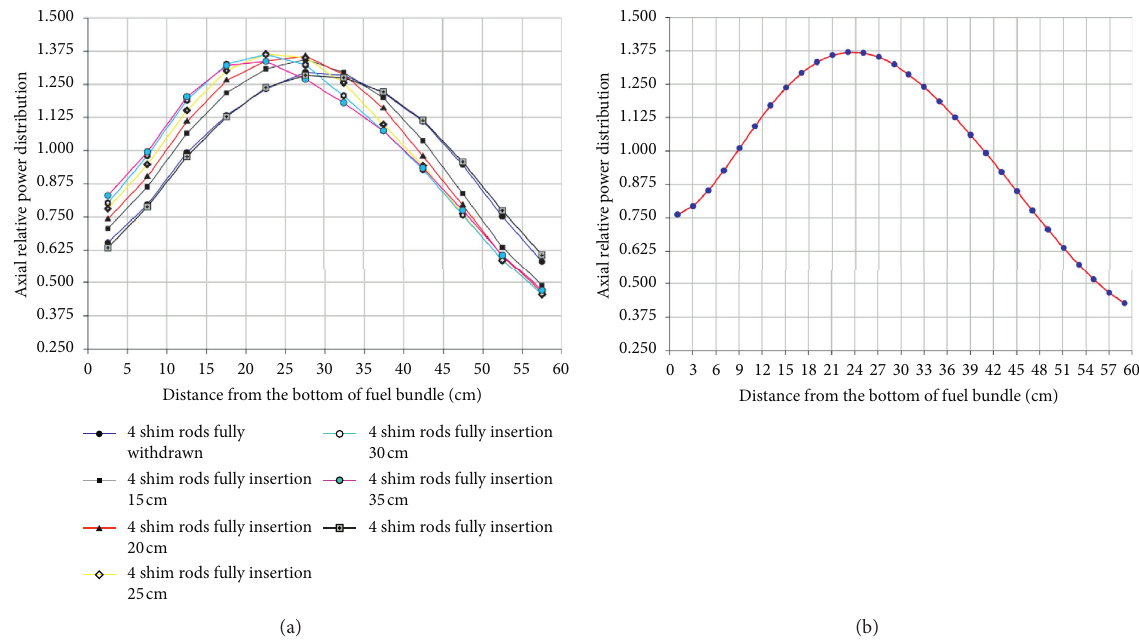
Figure 6: Axial relative power distributions (power peaking factors) of the hottest FB (at cell 10–5) calculated by the MCNP5 code for different insertions (a) and for 25 cm insertion of 4 shim rods (b).